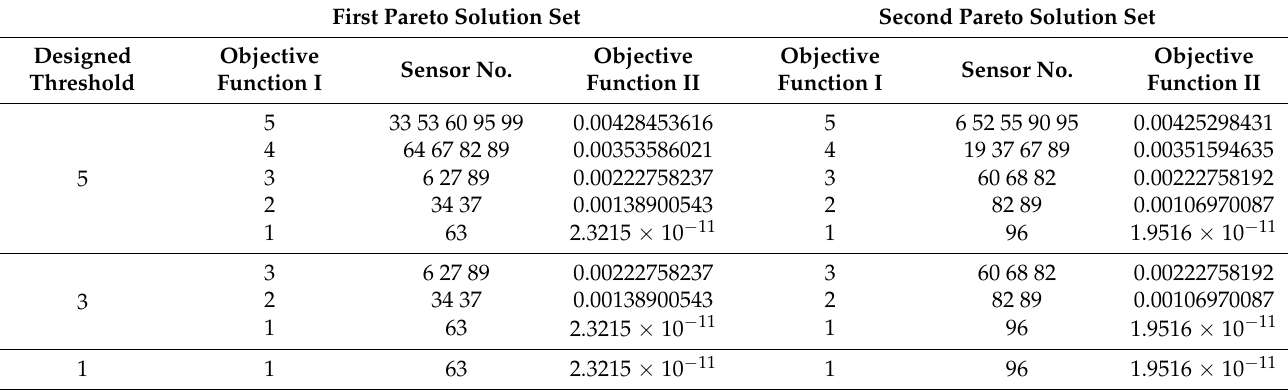
Table 4. The optimization results of the 11 × 11